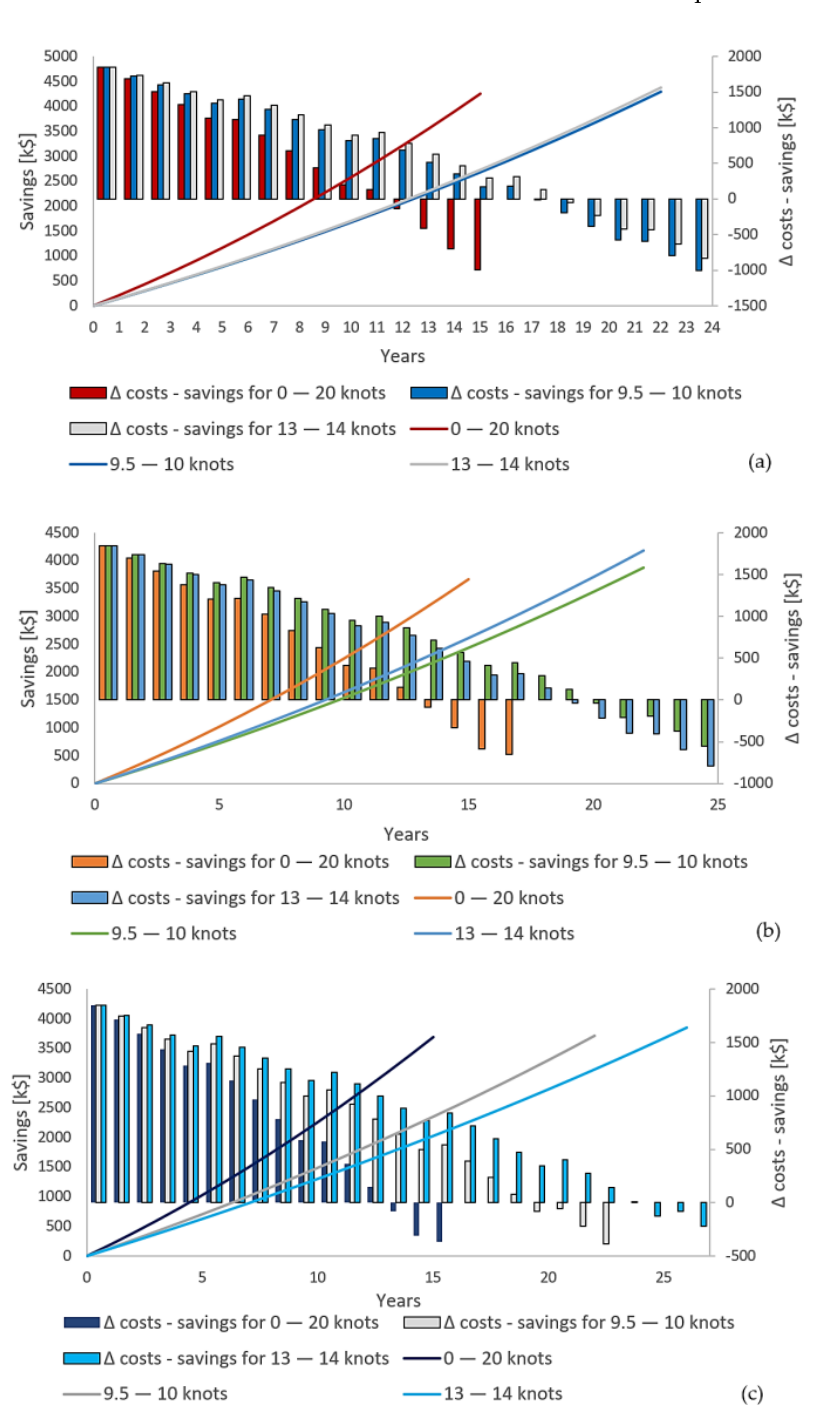
Figure 16. 6DOF simulation for a route from Barcelona to Alexandria in different rotor configurations: ( a ) D = 5 m and AR = 6; ( b ) D = 3 m and AR = 8; ( c ) D = 3 m and AR = 6.